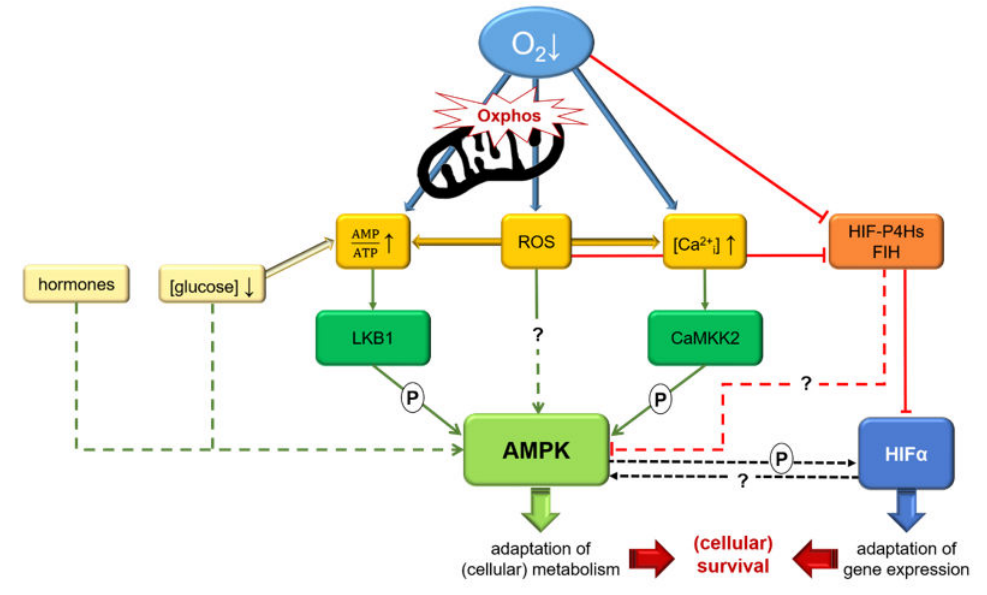
Figure 1. Graphical summary illustrating possible mechanisms regulating AMP-activated protein kinase (AMPK) activity under hypoxia. A decreased oxygen supply impairs oxidative phosphorylation (oxphos) in mitochondria and thus leads to increased AMP / ATP ratios, which will activate the canonical pathway of AMPK activation by LKB1. Besides LKB1, AMPK can also be phosphorylated by CaMKK2 subsequently to an increase of [Ca 2 + i ] under hypoxia. Impaired mitochondrial oxphos also causes formation of reactive oxygen species (ROS), which might not only induce these pathways but also activate AMPK directly. ROS are also supposed to inhibit hypoxia-inducible factor (HIF)-hydroxylase enzymes, which work oxygen-dependently and have been suggested to regulate AMPK in concert with HIF. Crosstalk between AMPK and HIF might help to orchestrate the adaptation to low oxygen levels as well. More details are given in the